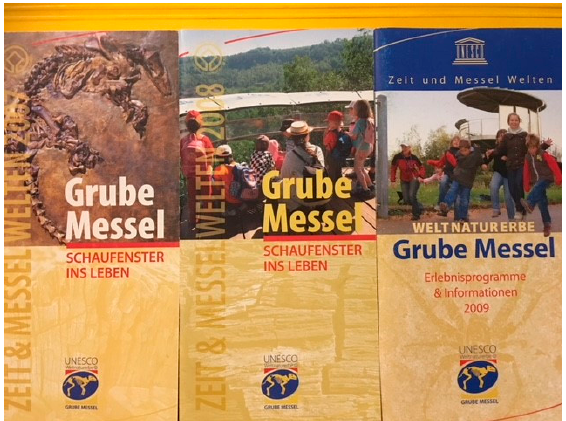
Figure 20. Promotional leaflets of Messel Pit WHS from 2007 to 2009 [76,77,80,81].